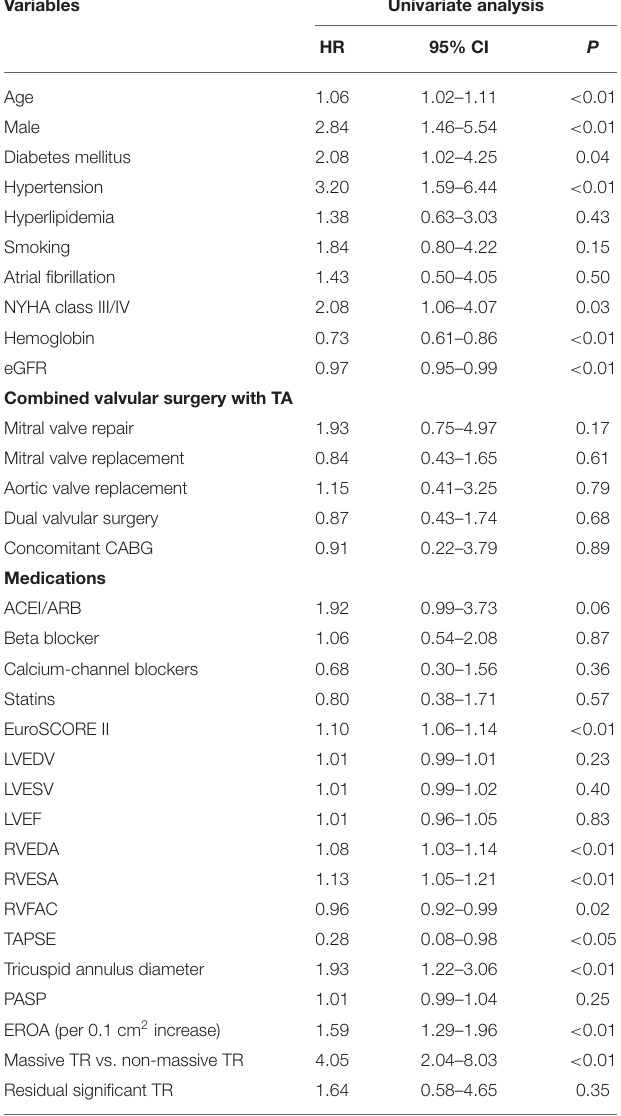
demographic parameters, traditional cardiovascular risk factors,